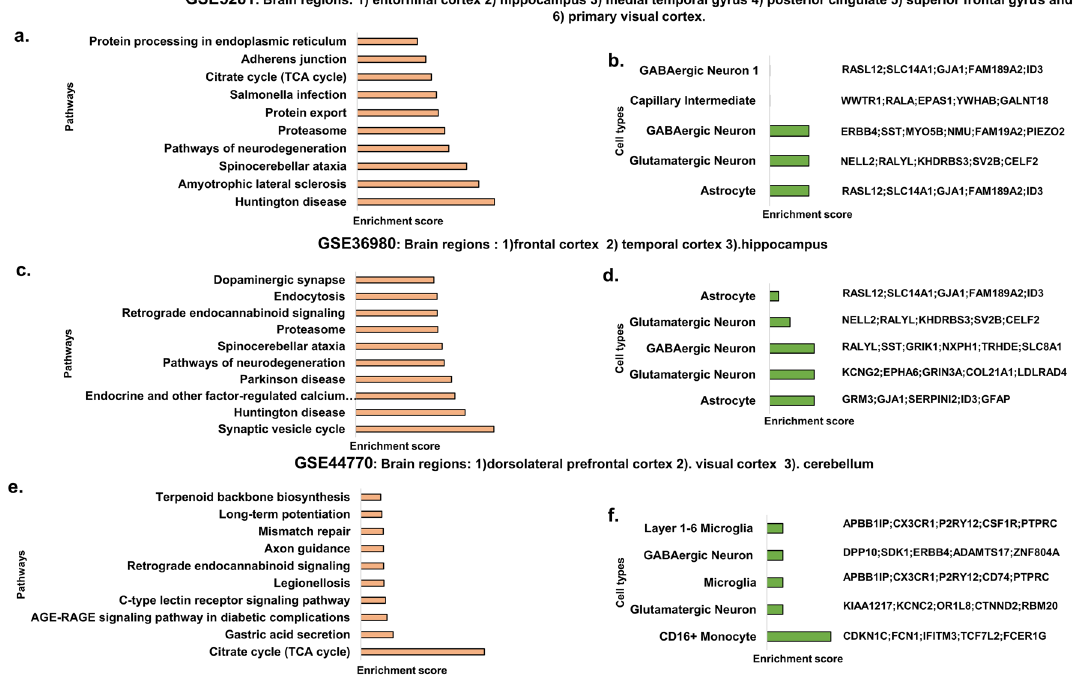
Figure 1. Gene expression data analysis of GSE5281, GSE36980, and GSE44770 GEO datasets. Pathway enrichment analysis of differentially expressed genes by Enrichr tool. Top significant pathways from datasets of ( a ) GSE5281 ( c ). GSE36980 ( e ). GSE44770. Cell type analysis and genes associated with each cell type ( b ). GSE5281 ( d ). GSE36980 ( f ) GSE44770. Figure generated using , Microsoft powerpoint 2019 MSO (Version 2212 Build 16.0.15928.20196)